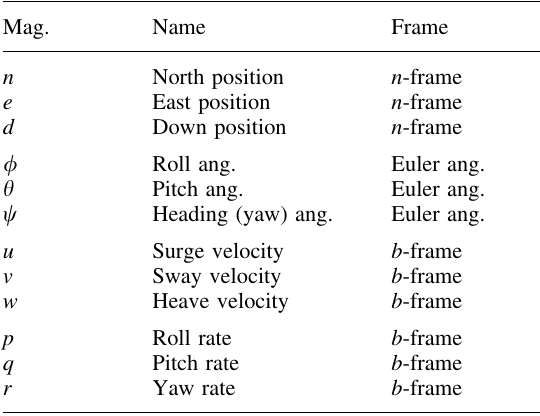
Table 1. Adopted nomenclature for the description of ship motion, and reference frames in which the different magnitudes are defined. Mag. Name